Question: Produce a descriptive caption suitable for publication.
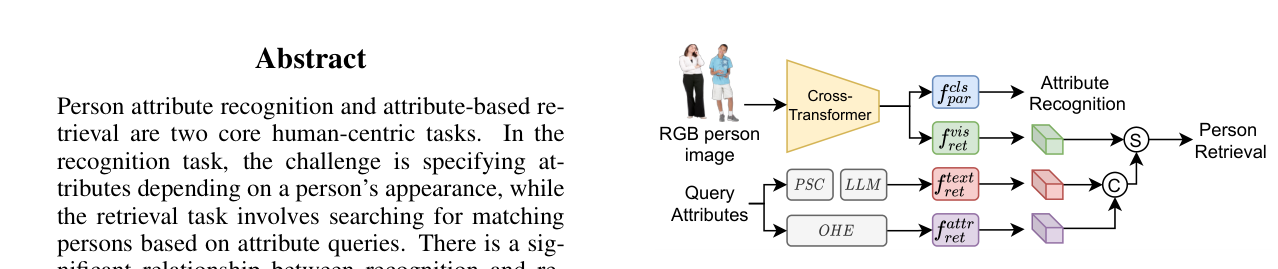
Answer: Unified CLEAR network for both person attribute recogni- tion & retrieval tasks. f cls par denotes the head classifier for attribute recognition. f vis ret denotes the auxiliary visual encoder. f text ret de- notes the auxiliary text encoder for the soft pseudo-description con- structed from query attributes. f attr ret denotes the auxiliary encoder for binary query attributes. C represents the concatenation oper- ation. S represents the scoring for matching query attributes and persons during the search process.